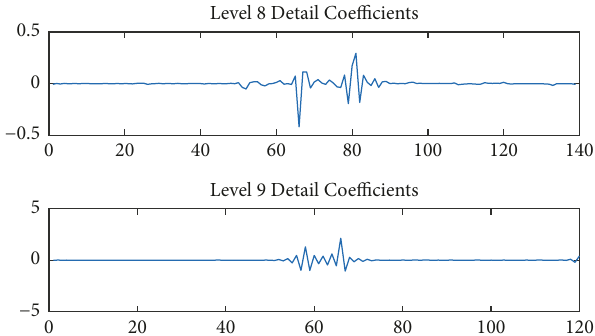
Figure 5: The waveletcoefficientdistribution, the detail component for levels 8 and